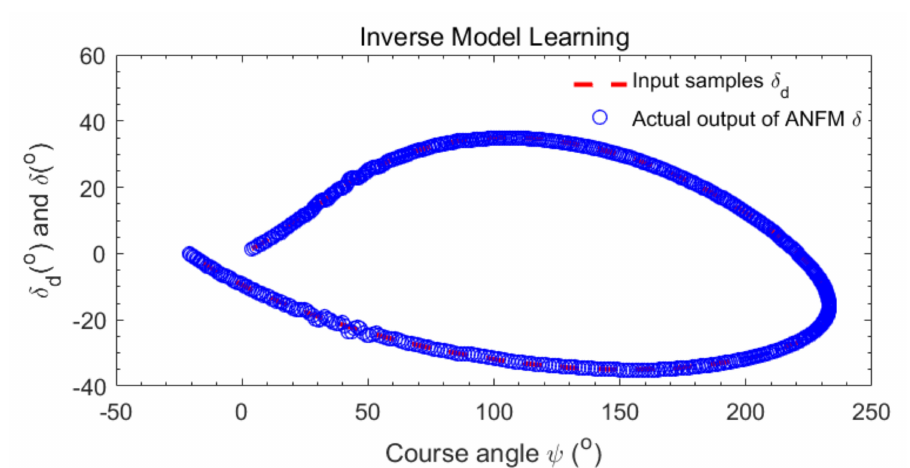
Figure 11. Comparison curve between input samples and ANFM actual outputs.